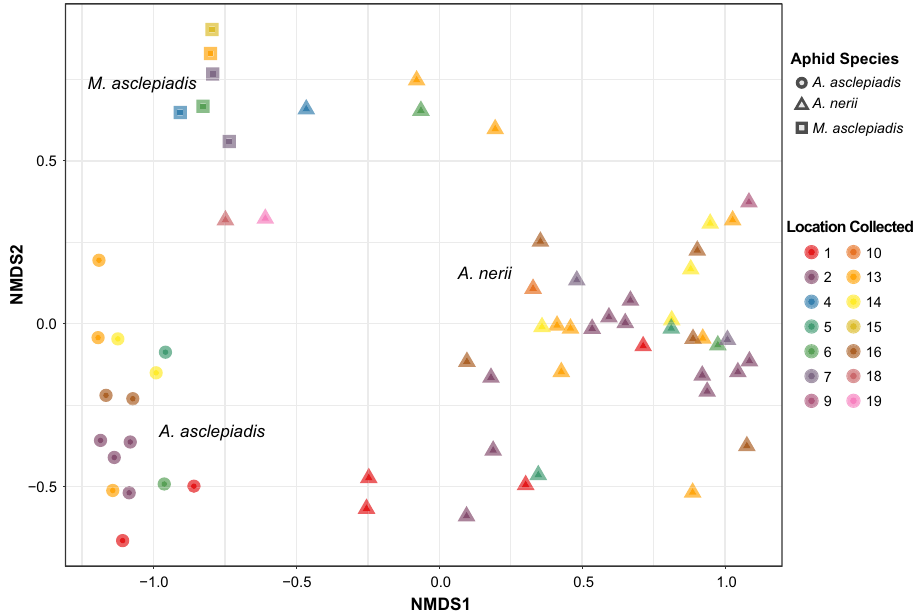
Figure 2. NMDS of Bray–Curtis dissimilarity showing how bacterial community structure varies across milkweed aphid species and